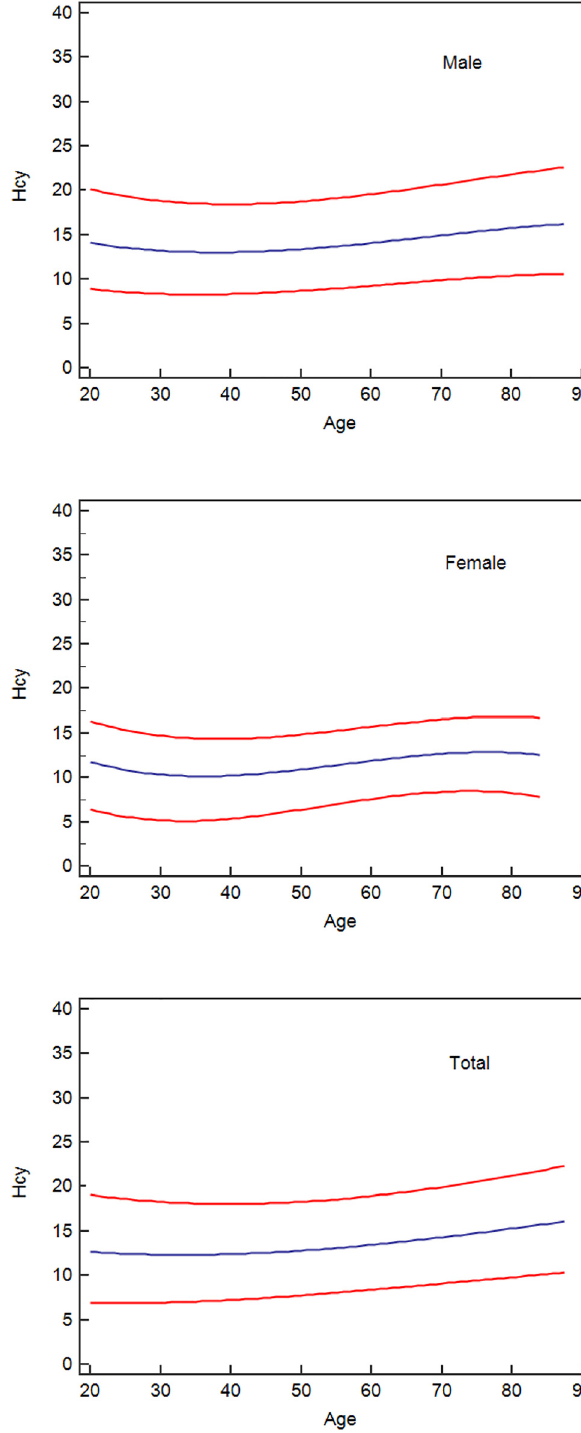
Figure 4: Continuous reference intervals for homocysteine (Hcy). Thebluelinerepresentsthe50thpercentileandthelower andupperred